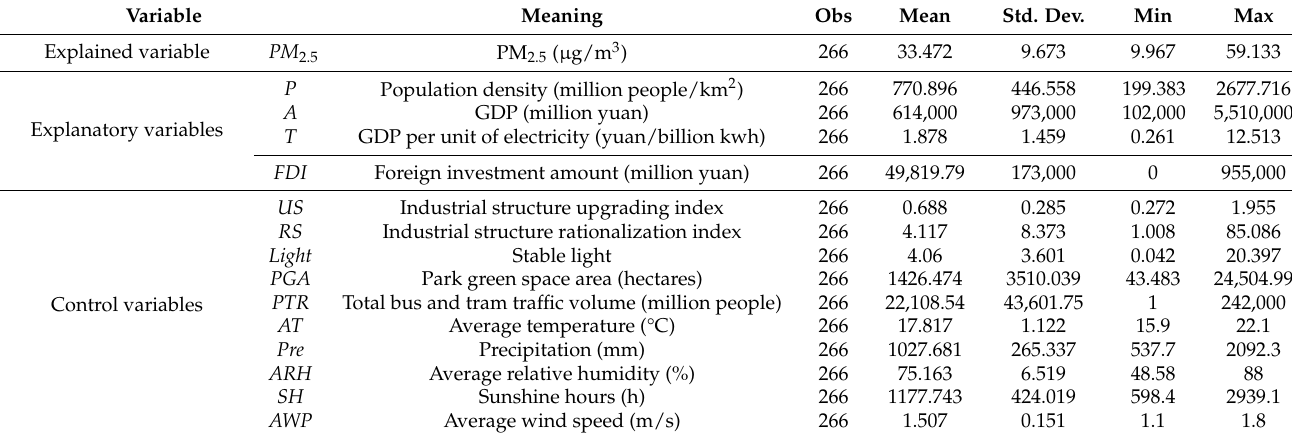
Table 1. Variables in the empirical model.